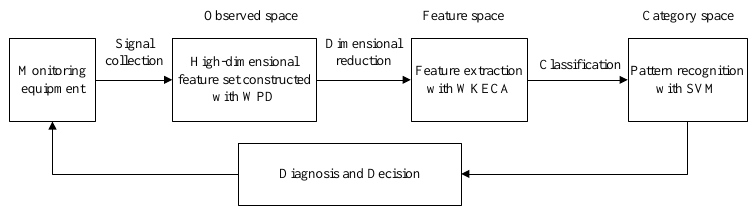
Figure 1. Implementation process of the proposed fault diagnosis method.